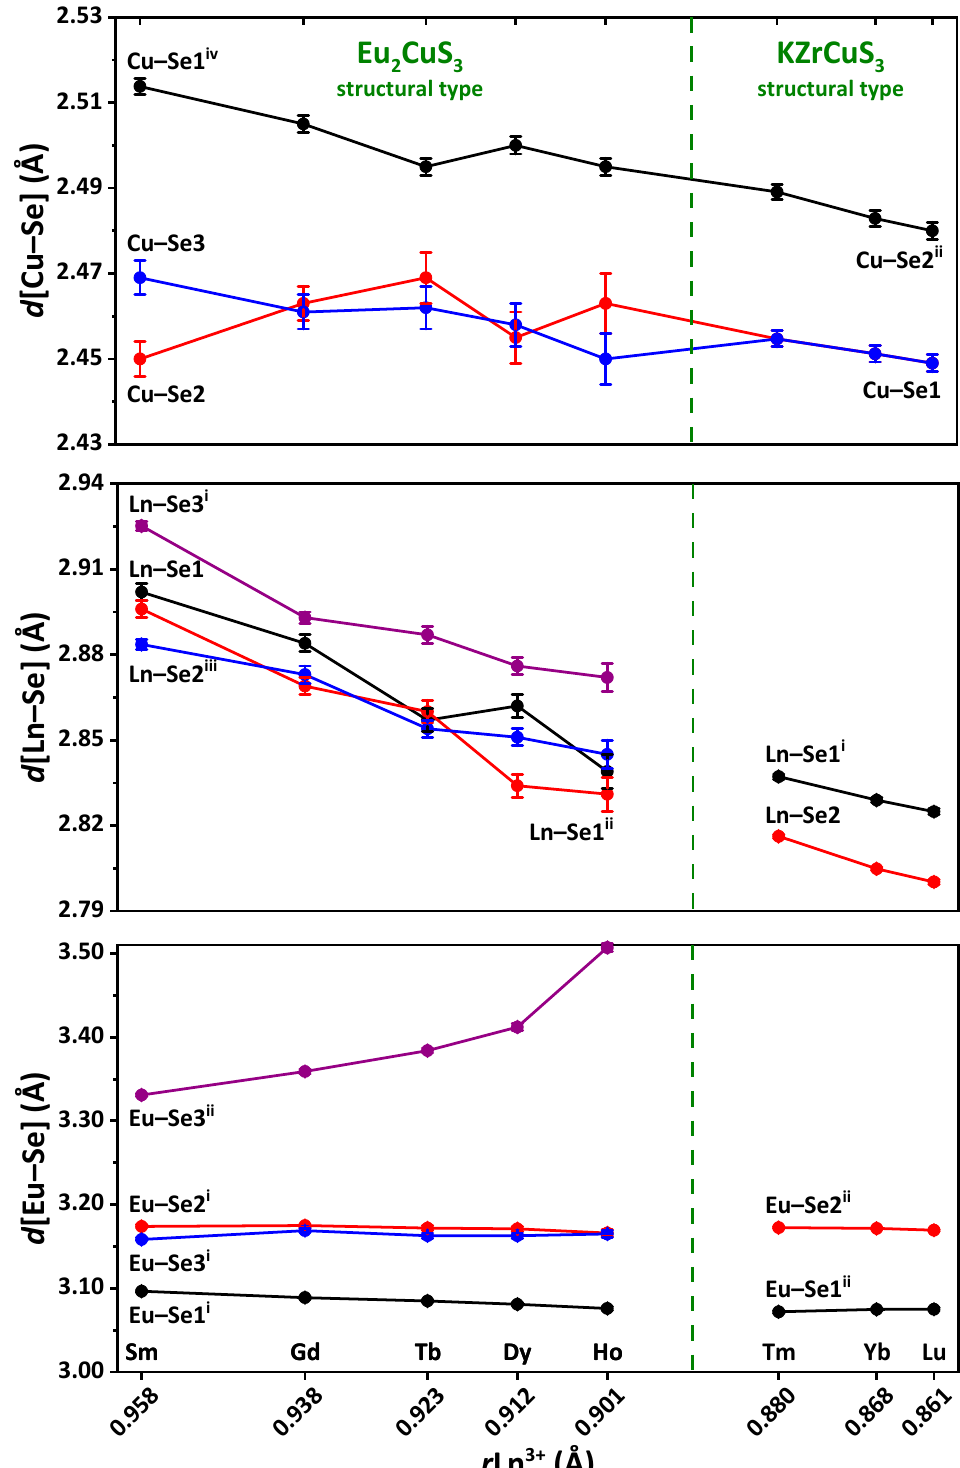
(Figure 3, Table S4 in the Supplementary Materials). A similar trend was observed for isostructural compounds EuLnCuS 3 [10] and SrLnCuS 3 [67].